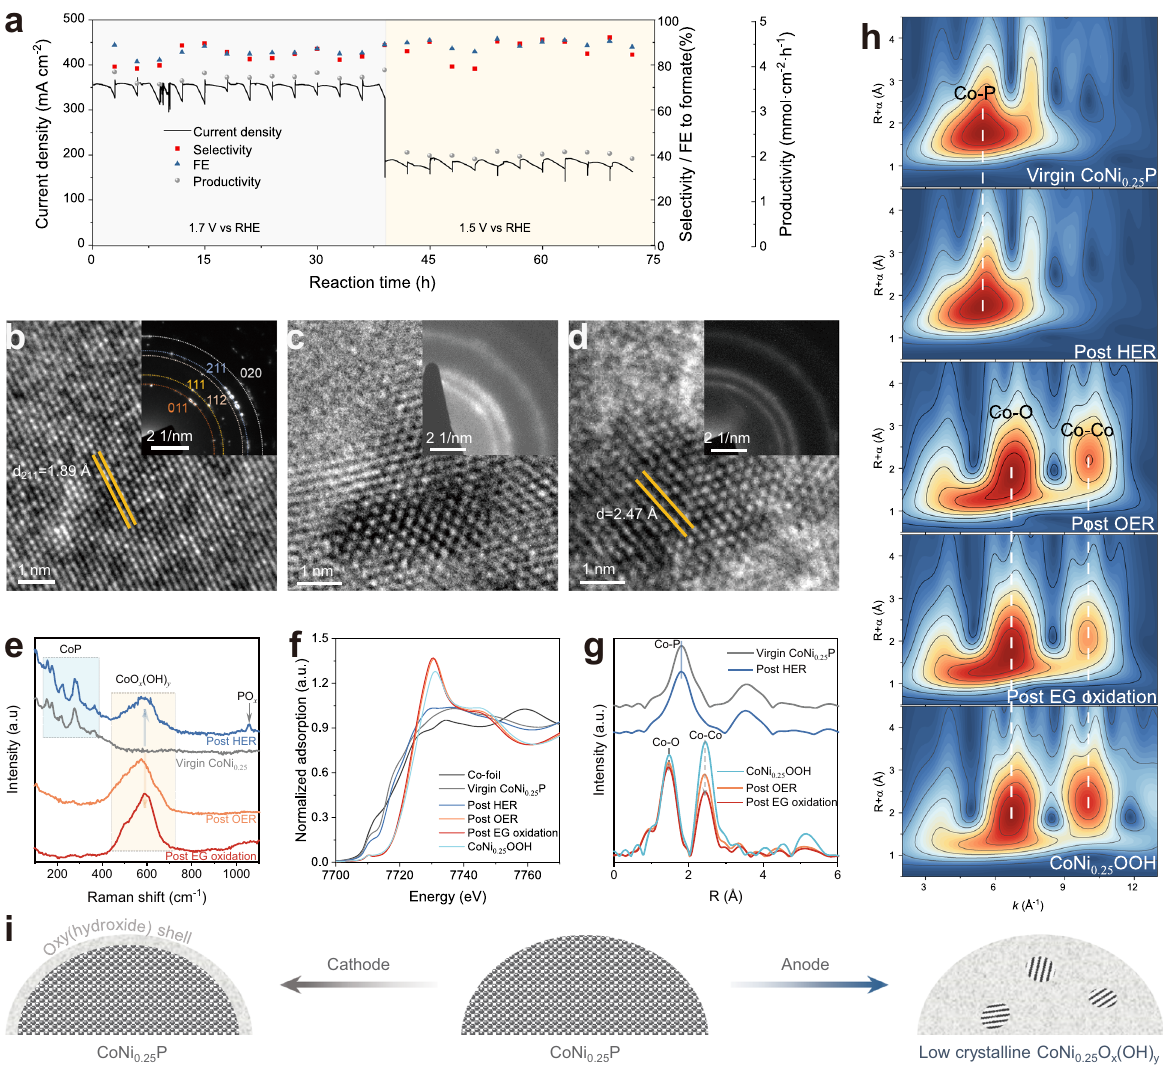
Fig. 5 Catalytic stability and structural evolution of CoNi 0.25 P catalyst. a Chronoamperometric stability test for EG oxidation at 1.7 V vs RHE for 13 cycles and 1.5 V vs RHE for 11 cycles. The electrolyte was refreshed every 3 h. b – d TEM images and corresponding SAED patterns of CoNi 0.25 P after HER ( b ), OER ( c ), and EG oxidation ( d ) reaction for 1 h. e Raman spectra, f Co K-edge XANES pro fi les, g Co K-edge EXAFS spectra, and h Wavelet transforms for Co K- edge EXAFS spectra for virgin and spent CoNi 0.25 P. i Schematic illustration of the structural evolution of CoNi 0.25 P catalyst under reaction